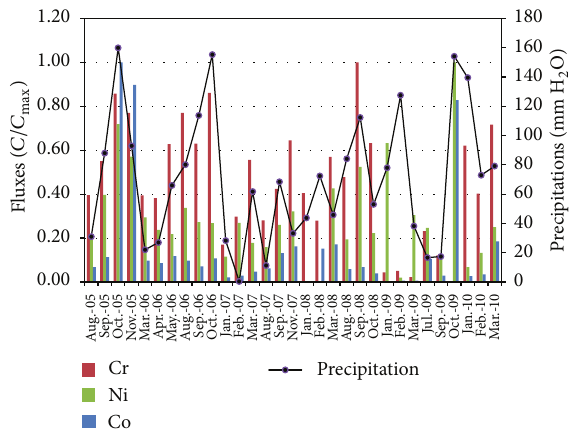
Figure 2: Average depositions of inorganic micropollutants for deposimeters D1, D2, D3, and D4 from January 2005 to May 2006.